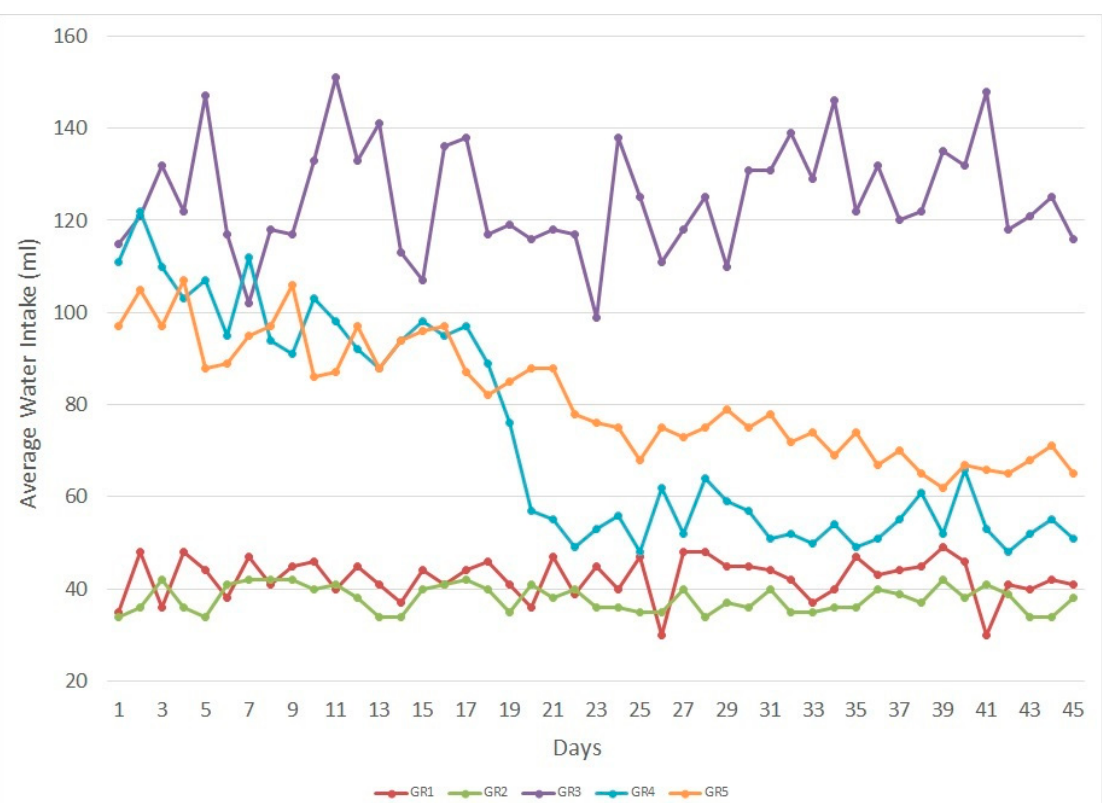
Figure 2. Average water intakes for 45 days.